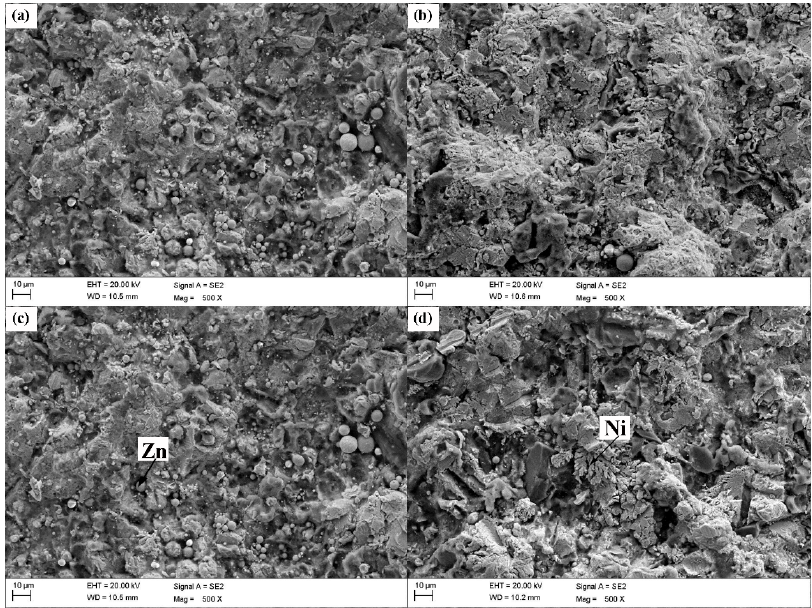
Figure 2. Scanning electron micrographs of the composite coatings with different amounts of Ni powders:( a ) 10 wt %,( b ) 15 wt %, ( c ) 20 wt %, and ( d ) 25 wt %. Arrows indicate intact spherical Zn particles and dendritic Ni particles.